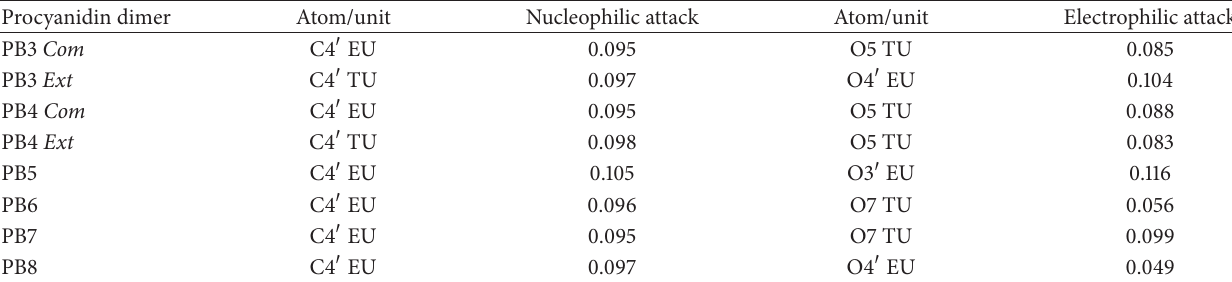
Table 4: Fukui indices of the procyanidin dimers calculated by the M05-2X/6- 31 G ∗∗ DFT method using the Hirshfeld charge population analysis in an aqueous medium (SMD